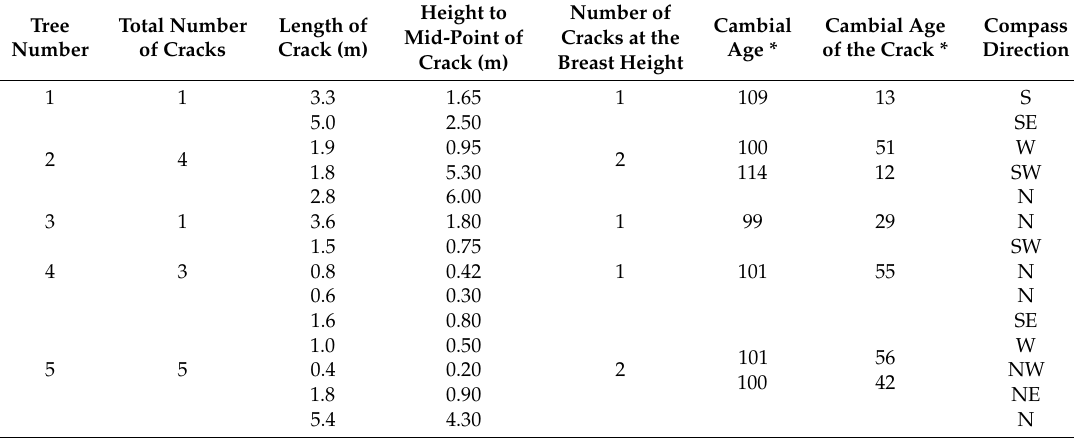
Table 2. Number, length of crack (measured on scar on bark), height to midpoint of crack (from the tree base), compass direction of the cracks, and cambial age *.